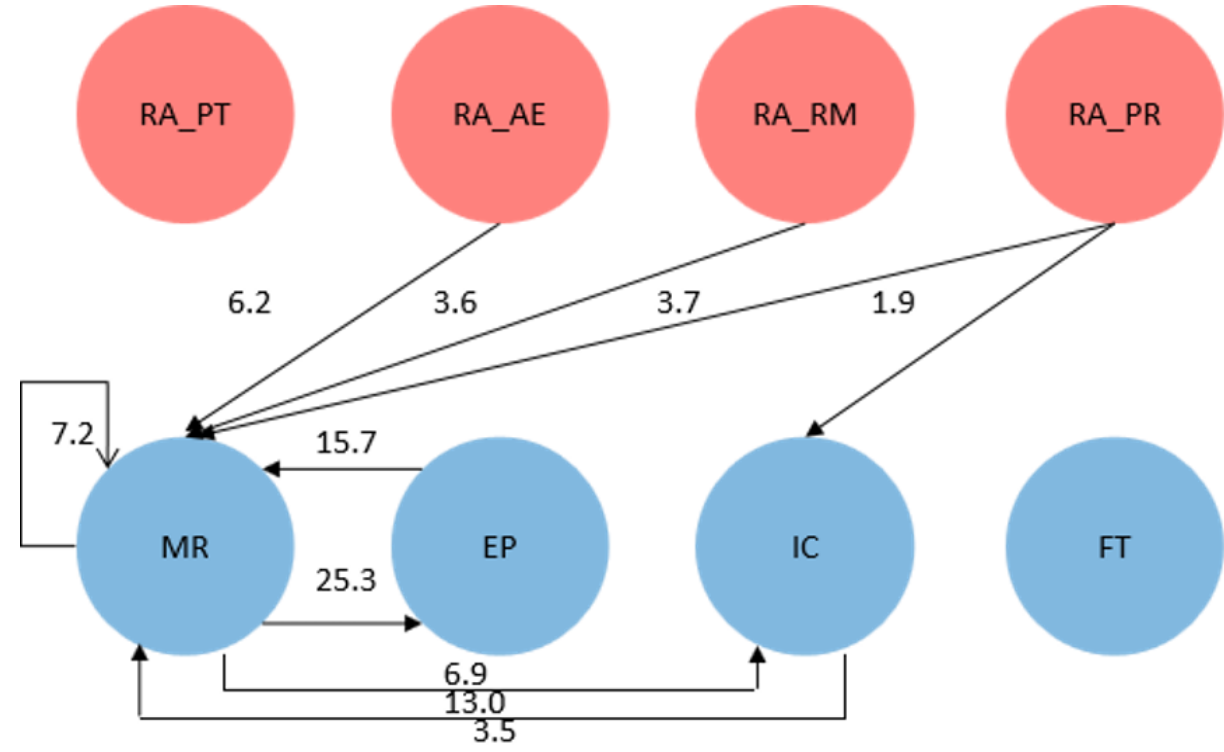
Figure 7. Behavior transition graph for the board game. AE: activity executions; EP: edit profiles; FT: finish tasks; IC: invite cooperation; MR: manage